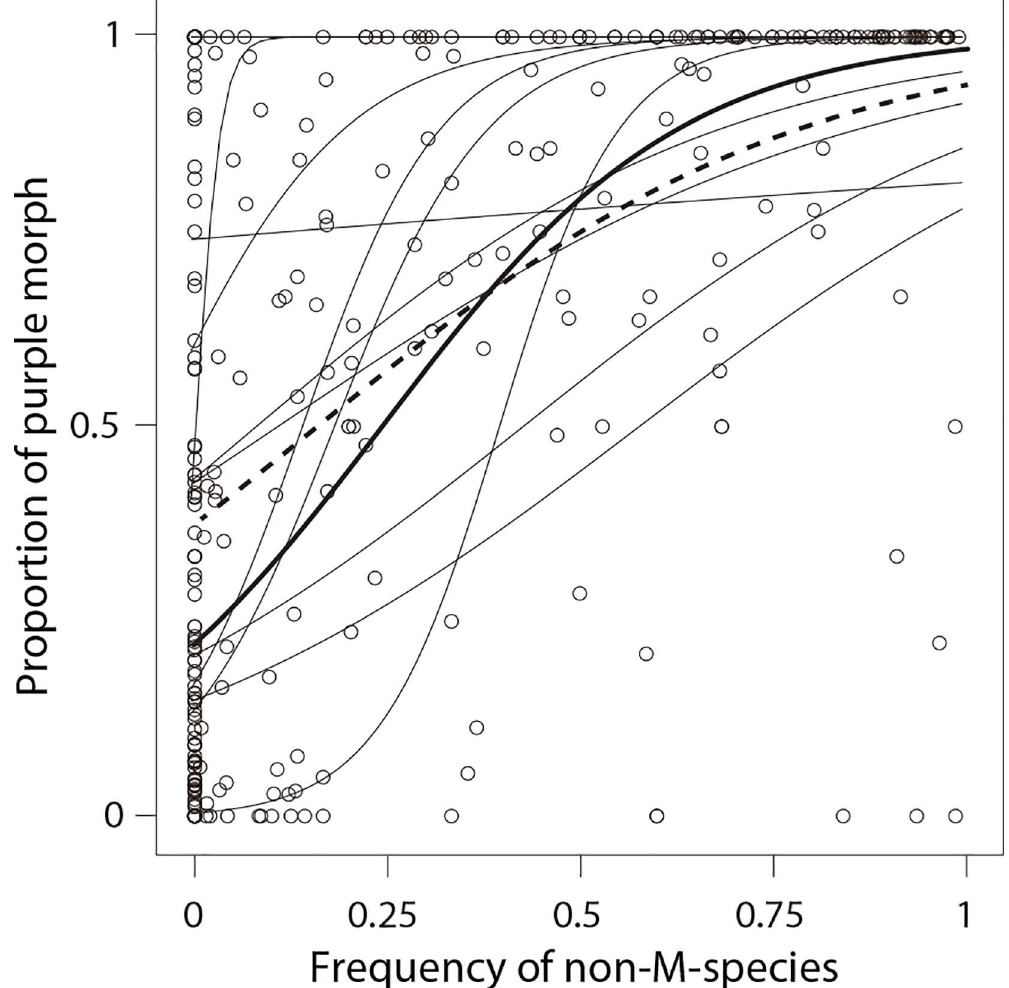
Fig 5. Relationship between the relative abundance of L- and S-species in the Sisyrinchium community and the proportion of purple morphs. Thin lines are logistic regressionlines for each study population. The bold line and the dashed line indicate the weightedand non-weighted regressionlines for all populationsexcept the monomorphic